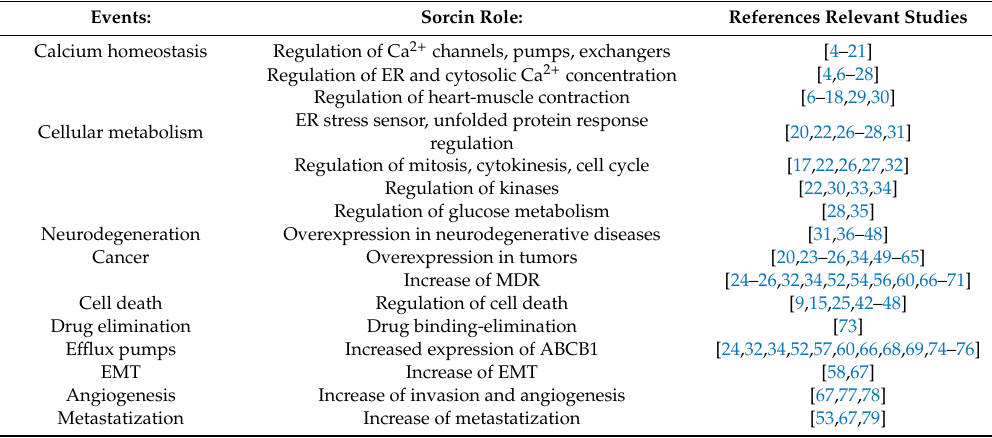
Table 1. Sorcin: Roles in cells, tumors, and multidrug resistance